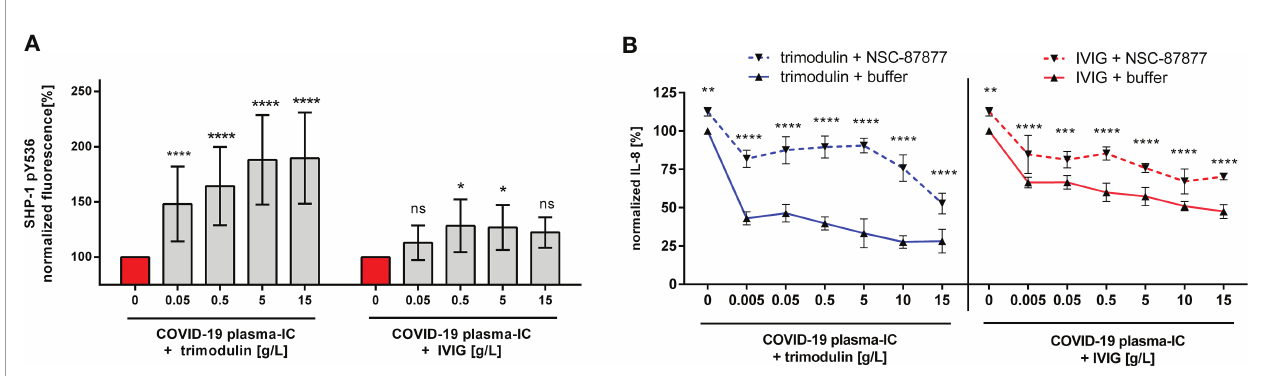
FIGURE 4 | Stronger immune modulation by trimodulin due to more potent ITAMi signaling. (A) Phosphorylation of SHP-1 at tyrosine 536 (pY536). Cells were treated for 1 h with COVID-19 plasma-IC and indicated trimodulin or IVIG concentrations for 90 min. Cells were fi xed, permeabilized, and stained with anti-phospho SHP-1 pY536 antibody. Fluorescence signal was measured by fl ow cytometry and normalized to buffer treated cells. (B) Blocking of SHP-1 phosphatase reduces immune modulatory effects. Cells were treated as in (A) , but additional pre-incubation with 200 µM SHP-1 inhibitor NSC-87877. IL-8 release was normalized and compared between NSC-87877 (dotted lines) or buffer treatment (solid lines). Incubation of cells with trimodulin (blue lines) or IVIG (red lines) is shown with or without SHP-1 inhibitor. Values represent mean of six independent experiments. Statistics: Two way ANOVA; Tukey ’ s multiple comparisons test, 95% con fi dence interval. ns, not signi fi cant, *p ≤ 0.05, **p ≤ 0.01, ***p ≤ 0.001, ****p ≤